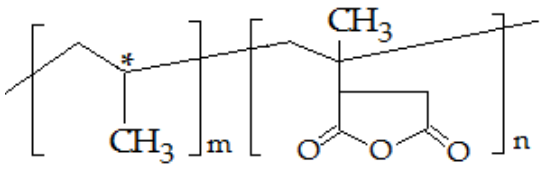
Figure 4. The radical position in the PP molecules grafted with MA.